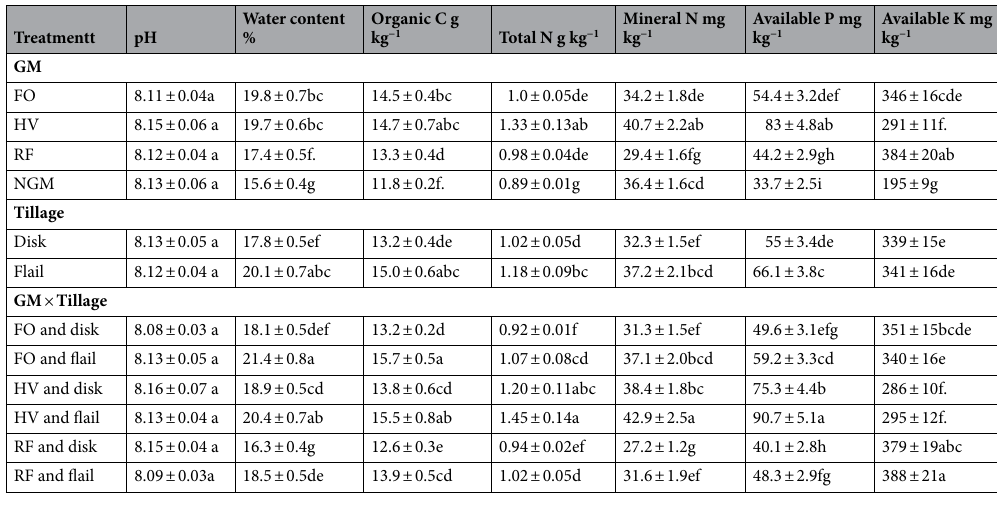
Table 1. Selected properties of walnut orchard soils (0–20 cm) as affected by green-manure and termination method. The values are means ± standard deviations (n = 3). Values followed by different letters differ significantly (LSD test, P < 0.05). The P values of ANOVA are shown in Table S1. GM green manure; FO February orchid; HV hairy vetch; RF rattail fescue; NGM no green